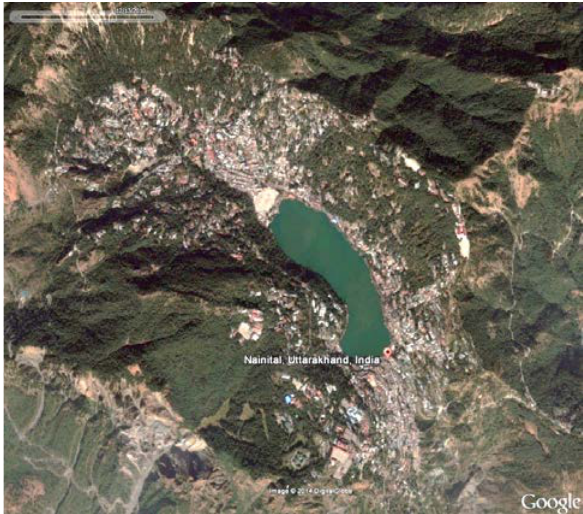
Figure 2: Satellite image showing Nainital Lake and the urbanized areas surrounding the lake. Background data: GoogleEarth, imagery from 13 th December 2010.